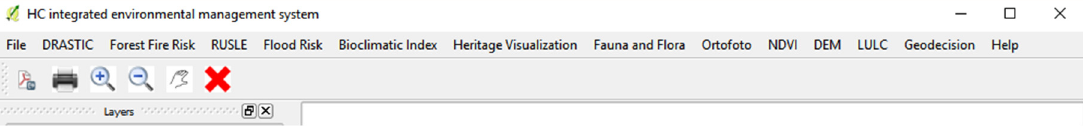
Figure 4. Herdade da Contenda Integrated Environmental Management System (HCIEMS) graphic interface.